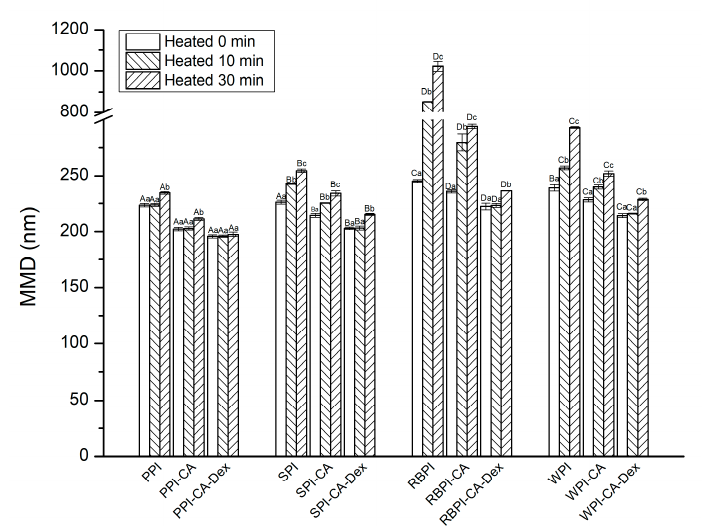
Figure 8. The MDD of nanoemulsions stabilized by NP, PC, and PCD samples after heating treatment. A–D represented that there were statistically differences ( p < 0.05) in MDD among nanoemulsions stabilized by four NPs, four PCs or four PCDS in same heat conditions; a–c represented that there were statistically differences ( p < 0.05) in MDD among same samples in different heat